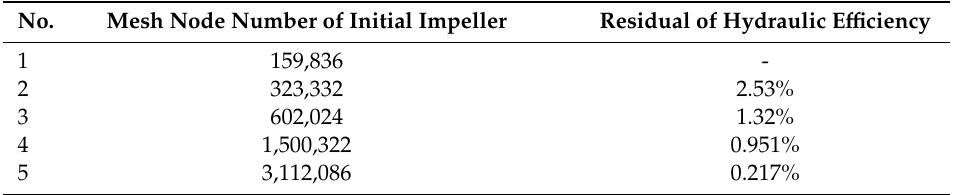
Table 1. Mesh independence check